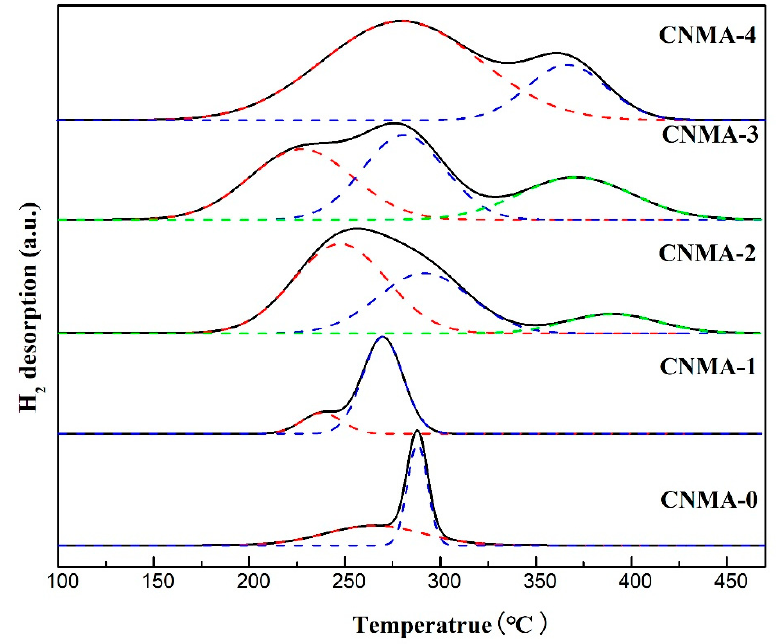
Figure 6. H 2 temperature-programmed reduction (H 2 -TPR) profiles of catalysts at 450 °C, the TPR, α , β , and γ peaks are shown as solid, dash dot, and dash and dot lines, respectively.